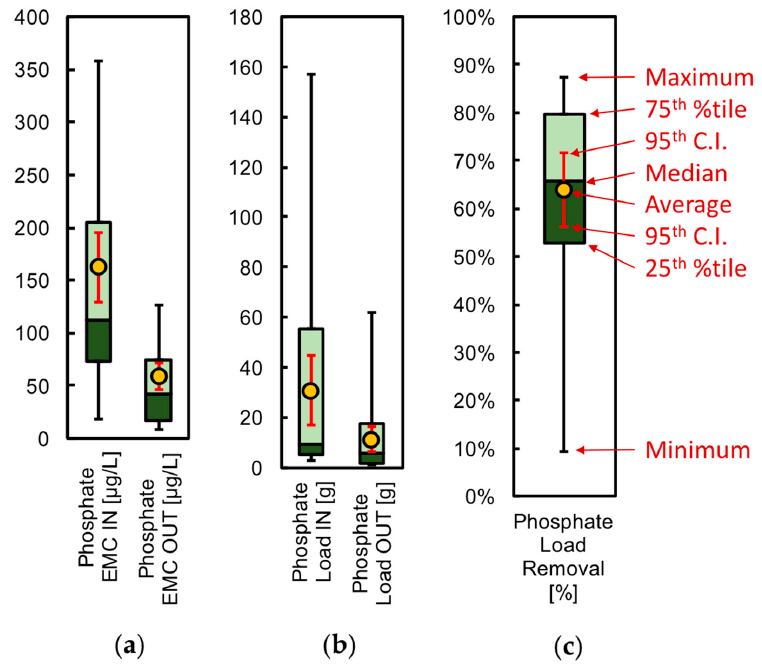
Figure 5. Phosphate statistics for n = 31 events in 2015 and 2016 for ( a ) influent (IN) and effluent (OUT) EMC; ( b ) influent (IN) and effluent (OUT) load; and ( c ) load capture (%). Note: %tile = percentile and 95th C.I. = 95% confidence interval.